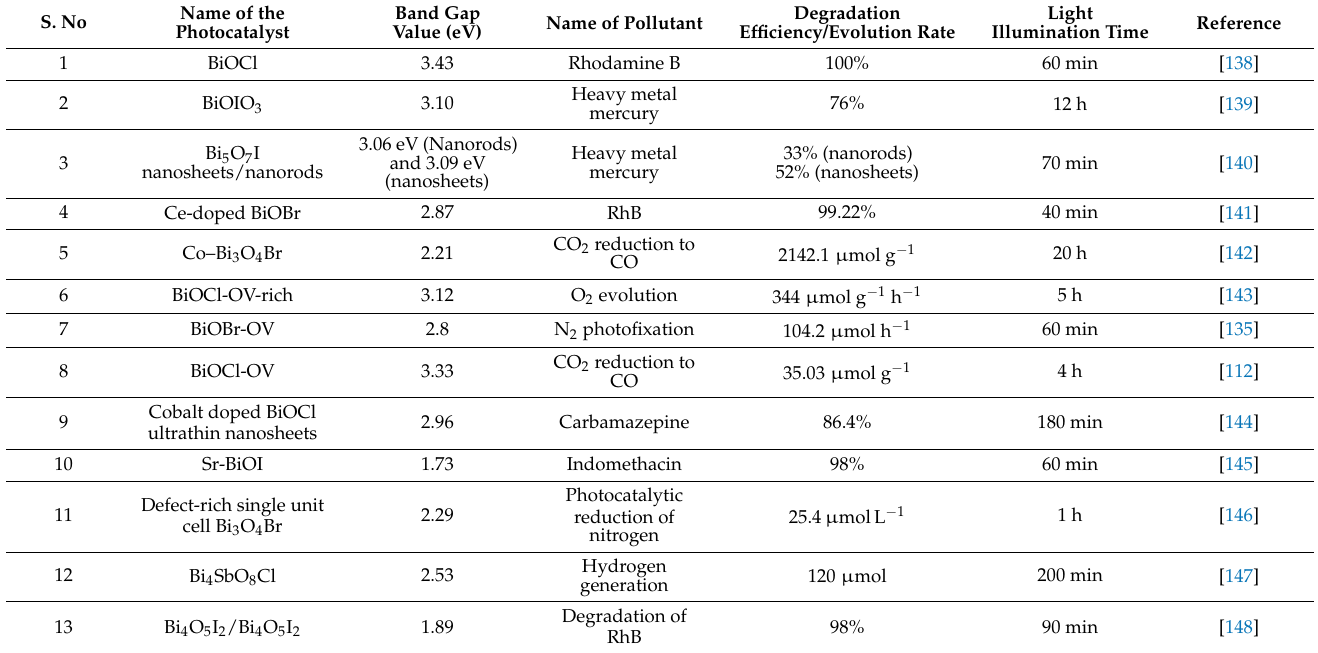
Table 2. Summarization of studies on various oxyhalide-based materials for solar-induced different photocatalytic